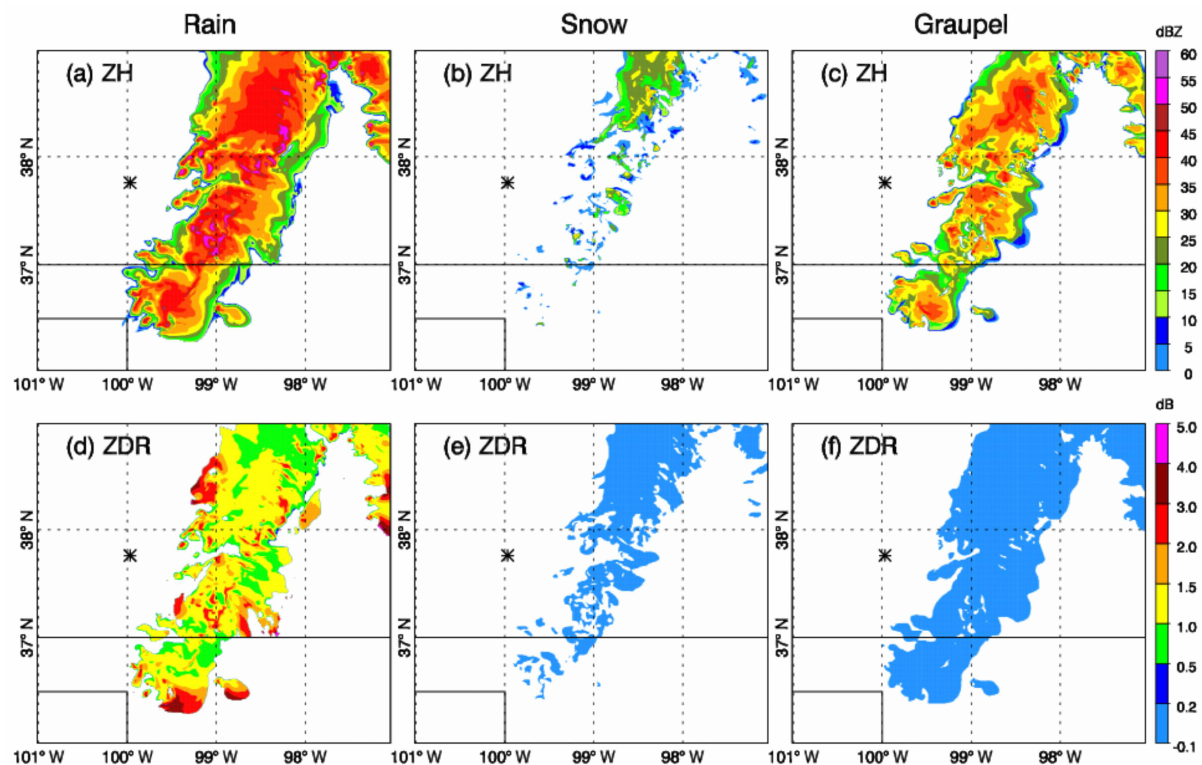
Figure 9. Z H in ( a – c ) and Z DR in ( d – f ) from WRF_Morr contributed by rain, snow, and graupel, respectively. All plots are for 2345 UTC 29 May 2018 at 3 km height. The star signs in the plots show the location of the KDDC